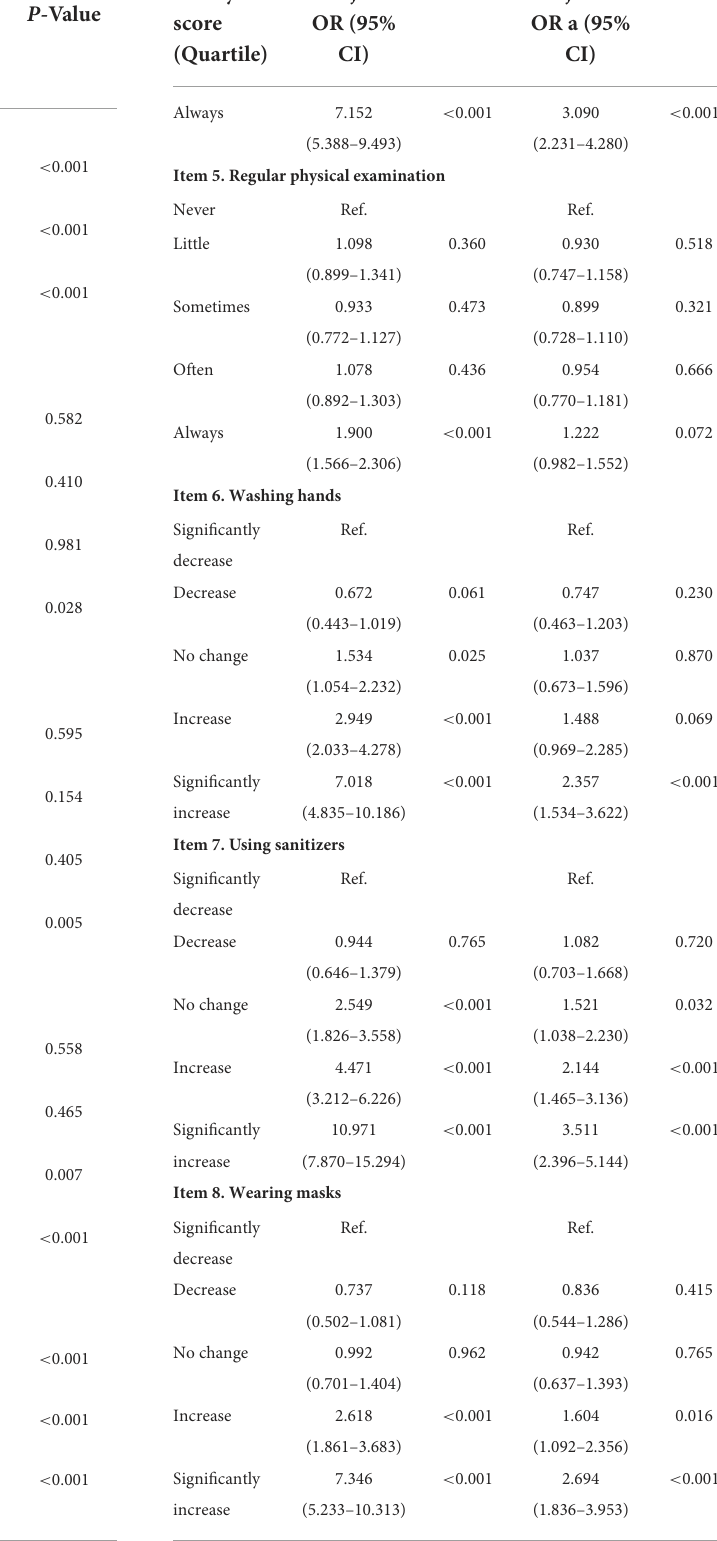
TABLE 2 The associations between lifestyle score, 12 items of lifestyles, and COVID-19 vaccination coverage